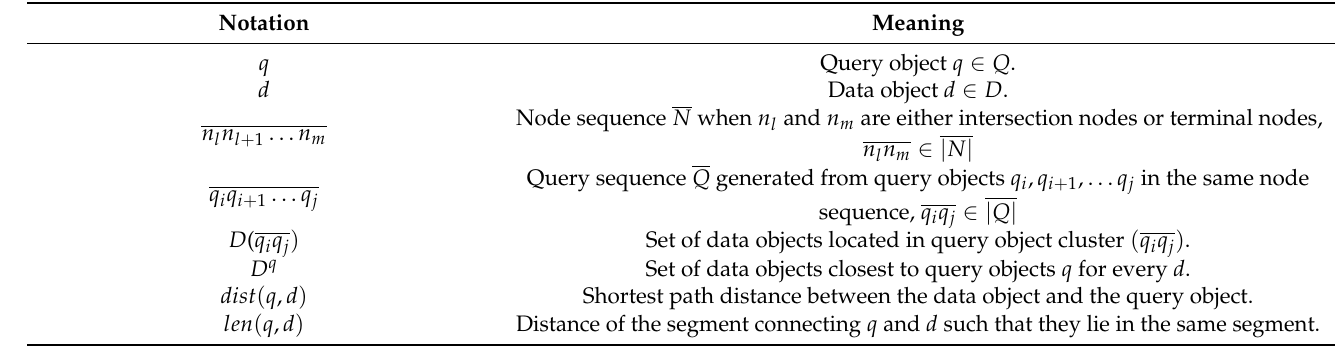
Table 1. Notation and their